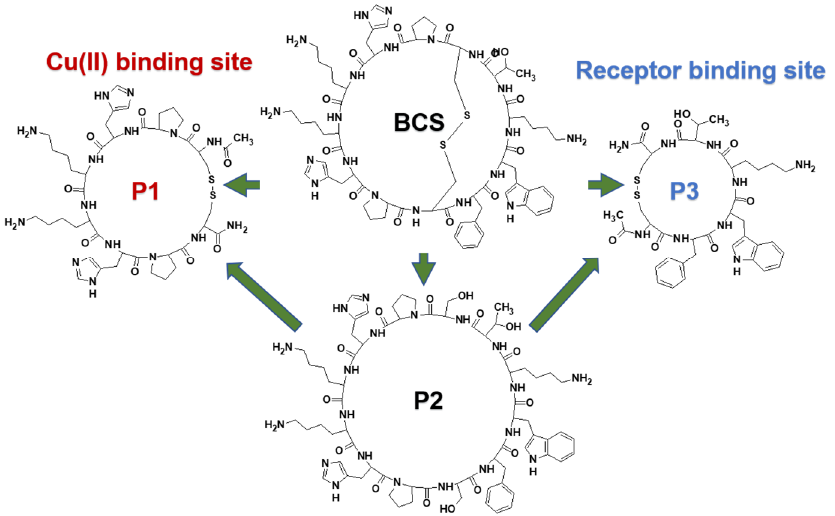
Figure 1. Structures of the bicyclic somatostatin analogue (BCS) (c(c(-S-Cys- Phe-Trp-Lys-Thr- Cys-S-)Pro- His-Lys-Lys-His- Pro)) [13] and the three designed peptides that were analyzed: P1. (Ac-c(-S- Cys-Pro-His a -Lys-Lys-His b -Pro-Cys-S-)-NH 2 ); P2. (c(Ser-Pro-His a -Lys-Lys-His b -Pro-Ser-Phe-Trp-Lys- Thr); and P3. Ac-c(-S-Cys-Phe-Trp-Lys-Thr-Cys-S)-NH 2 .